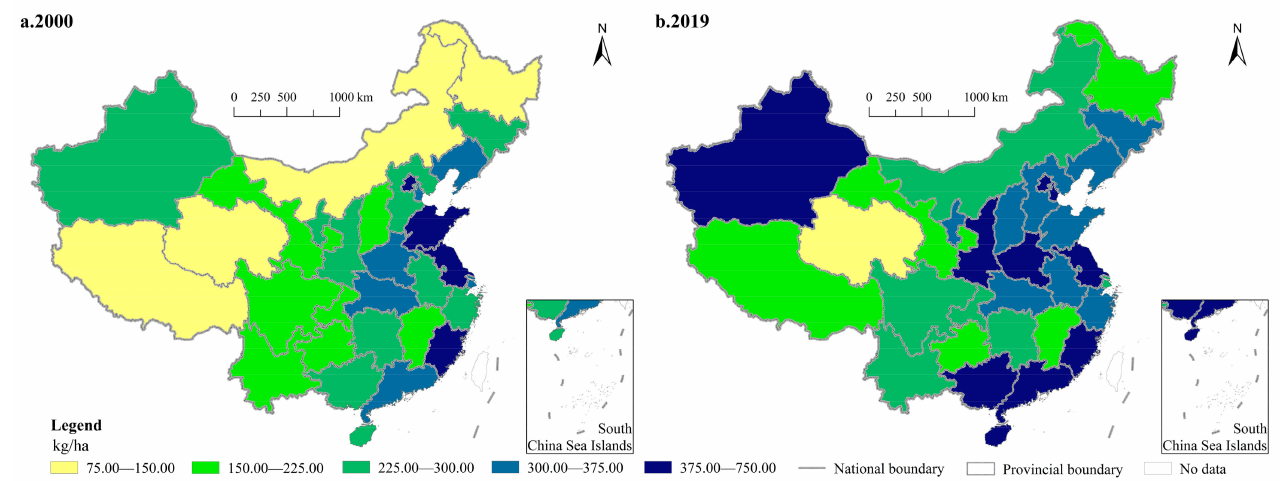
Figure 2. Spatial pattern of China’s provincial CFAI in 2000 ( a ) and 2019 ( b